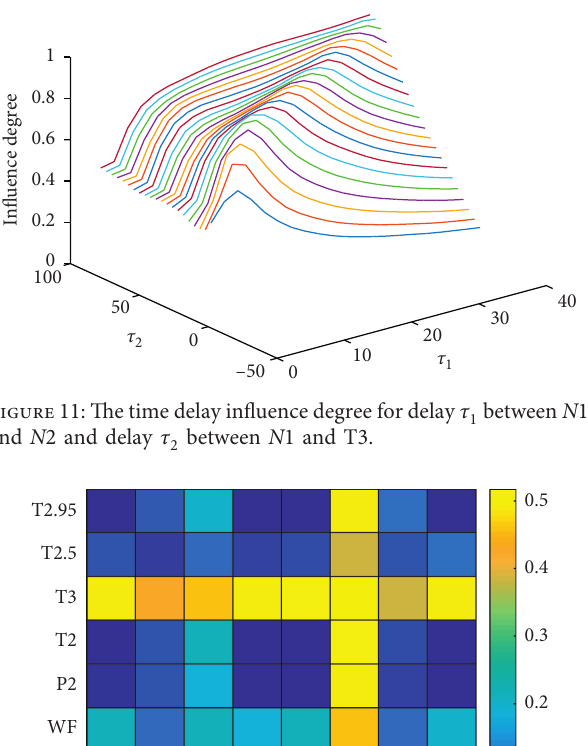
between N 1 and T3. 2